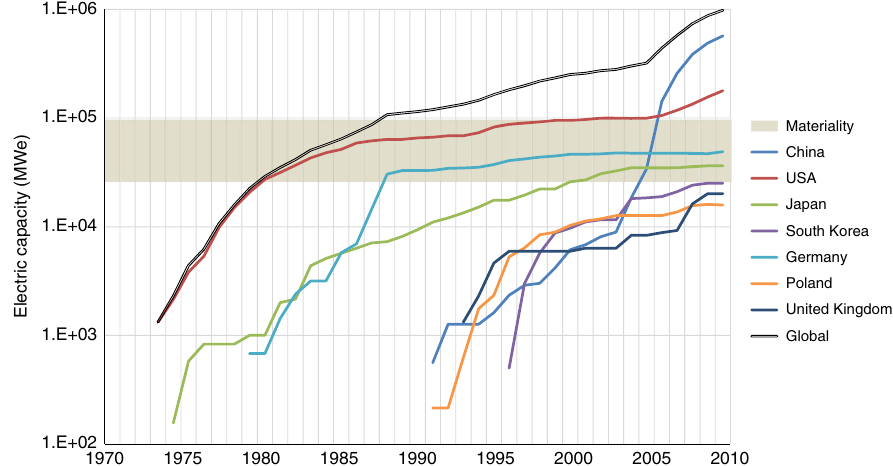
Fig. 2 Installed electric capacity of coal power with FGD in selected countries and globally. The horizontal bar indicates materiality, de fi ned as 1% of global primary energy consumption. The scale on the vertical axis is logarithmic because the contribution of different countries varies by an order of magnitude. Source data are provided as a Source Data